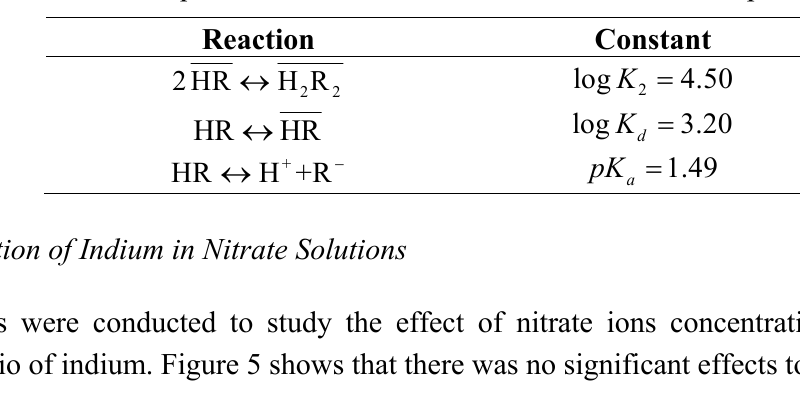
Table 1. The equilibrium constants of the different D2EHPA species